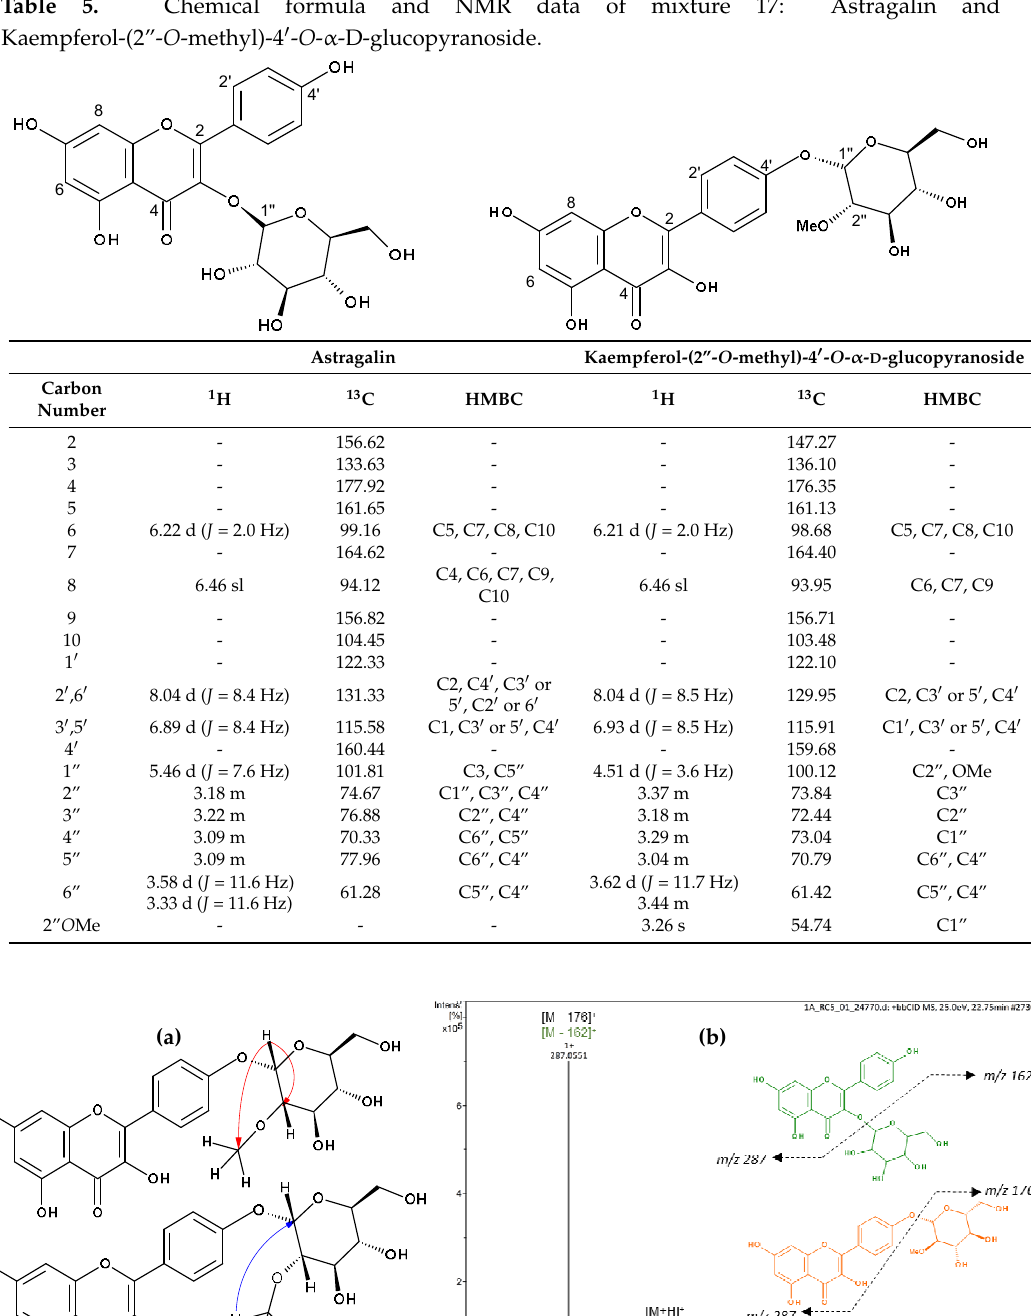
kaempferol-(2 (cid:48)(cid:48) - O -methyl)-4 (cid:48) - O - α - D -glucopyranoside ( 17 ; Table 5, Figure 2 and Figure S16–S21), which furnished a new compound. Molecules 2019 , 24 , x FOR PEER REVIEW 13 of 19 5. Chemical formula and NMR data of mixture 17: Astragalin and 5. Chemical formula and NMR data of mixture 17: Astragalin and Kaempferol-(2”- O -methyl)-4 (cid:48) - O - α -D-glucopyranoside.